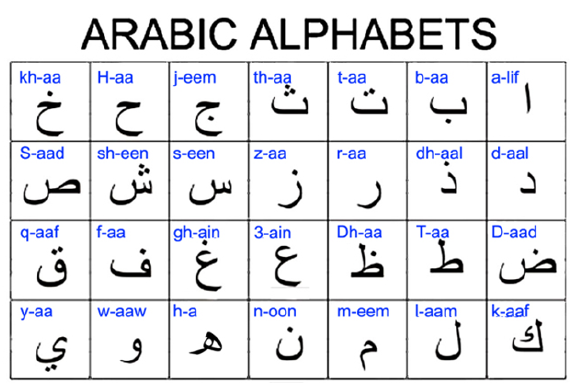
Figure 1. Alphabets of Arabic